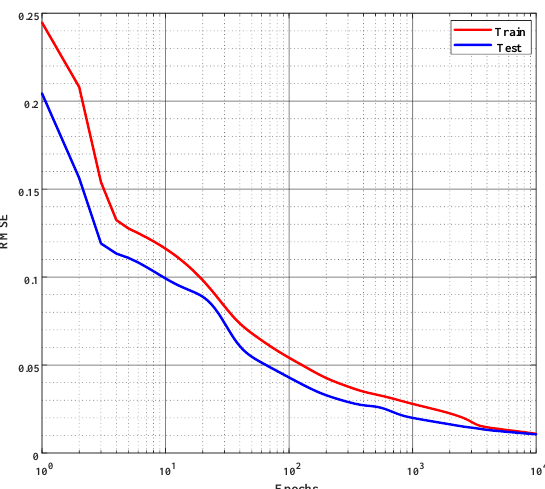
Figure 5. Architecture of artificial neural network (ANN) (9-20-15-1) for learning of % of inhibition. Biases of nodes are omitted in this figure, where four input terminals are used for indicating cell lines and three input terminals are to determine MTXs and other two input terminals are for the dose of MTX and QCT, respectively. Also, the single output terminal is for % of inhibition.